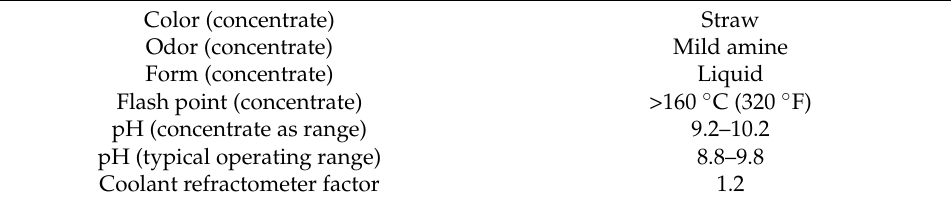
Table 5. Physical properties of MicroSol 585XT.